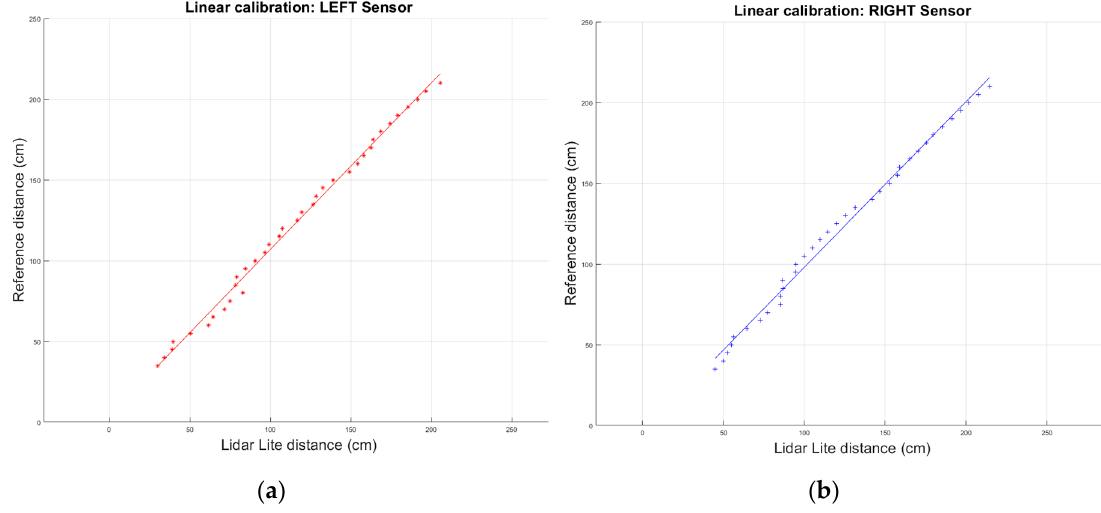
Figure 6. Distance sensor calibration. ( a ) Left sensor. ( b ) Right sensor.